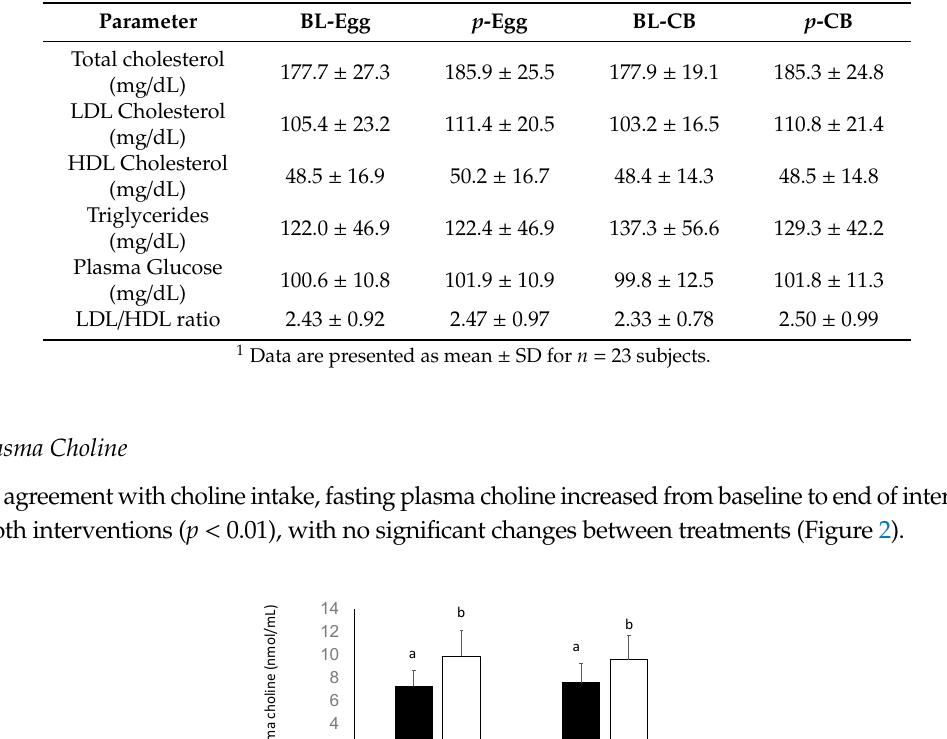
Table 4. Plasma total, LDL, HDL cholesterol, triglycerides, and glucose in subjects at baseline (BL), post ( p ) intervention with egg and choline bitartrate (CB) supplement 1 .